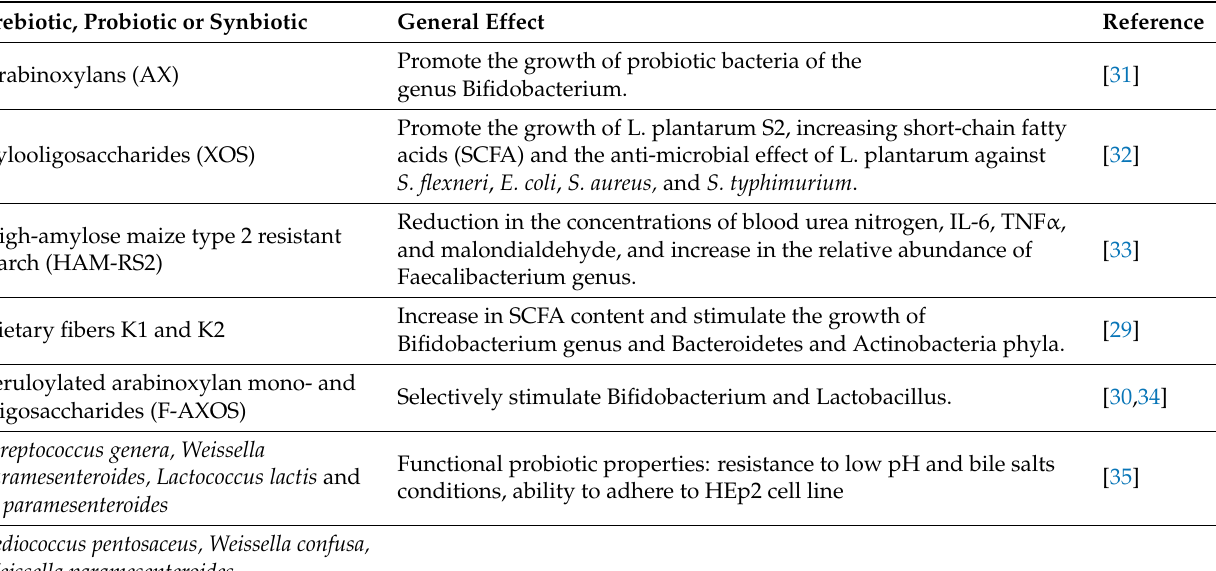
Table 1. Prebiotics, probiotics and synbiotics in